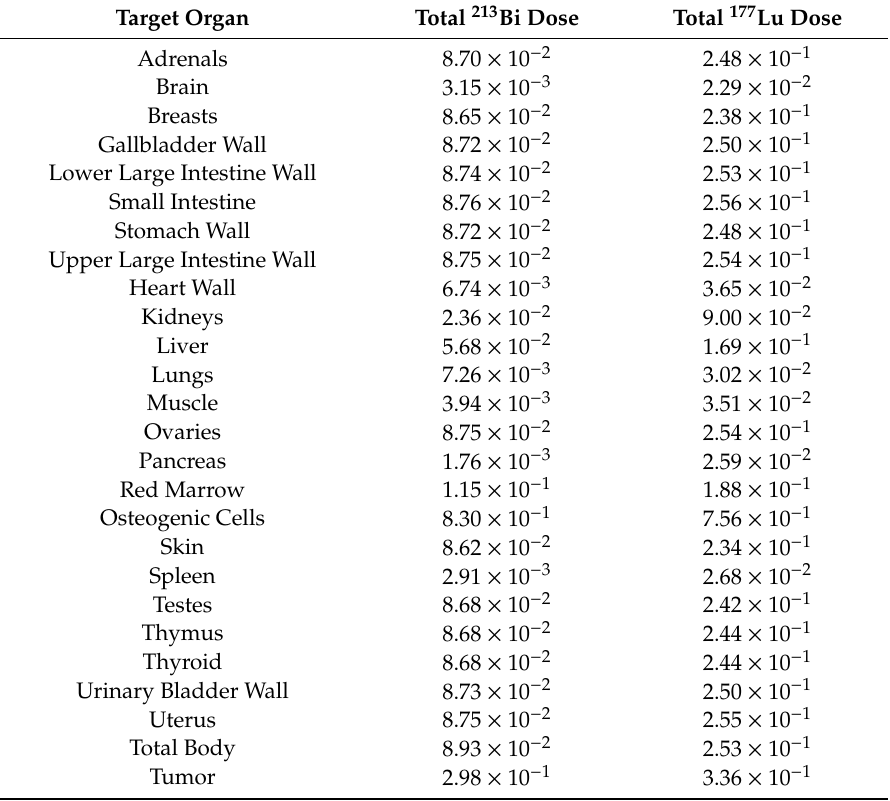
Table 2. Absorbed doses in cGy / 37 MBq to the normal organs and melanoma tumors in an adult man delivered by 213 Bi and 177 Lu. A Centigray-equivalent dose per 37 MBq administered, alpha multiplier = 5 was applied for 213 Bi tumor dose calculation. Complete dose tables can be found in the supplementary (Tables S2 and S3).